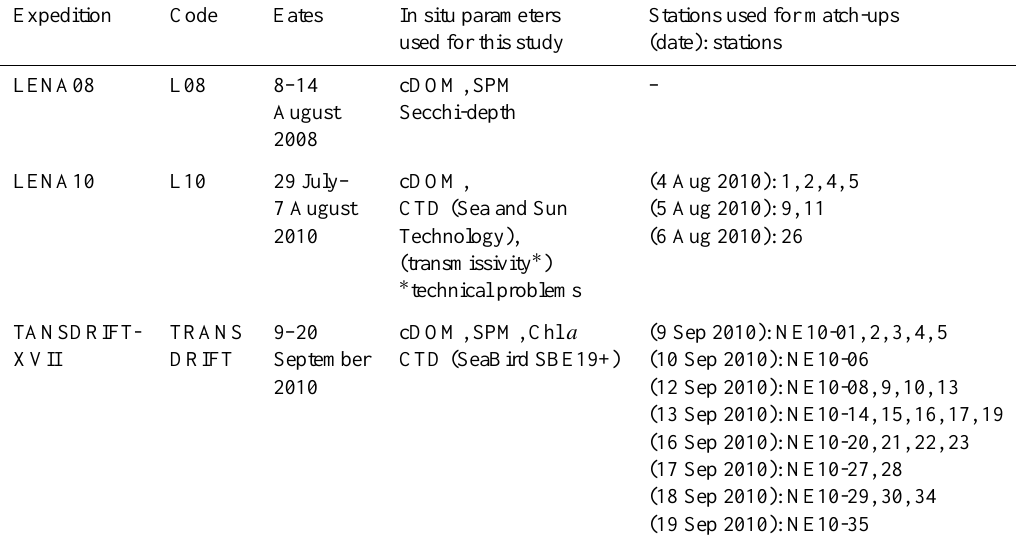
Table 1. LENA08, LENA10, TRANSDRIFT-XVII: in situ parameters and stations used in this study. Expedition Code Eates In situ parameters Stations used for match-ups used for this study